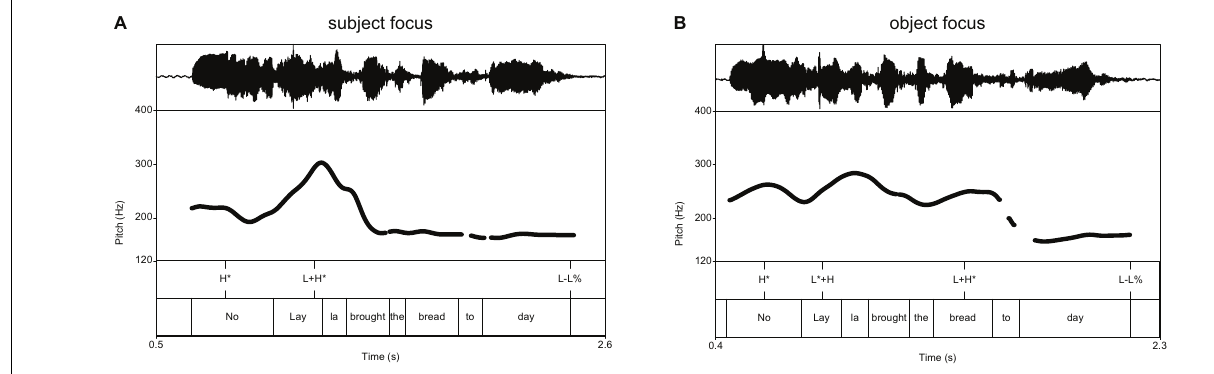
FIGURE 1 | Illustrative examples of (A) subject and (B) object focus in British English.